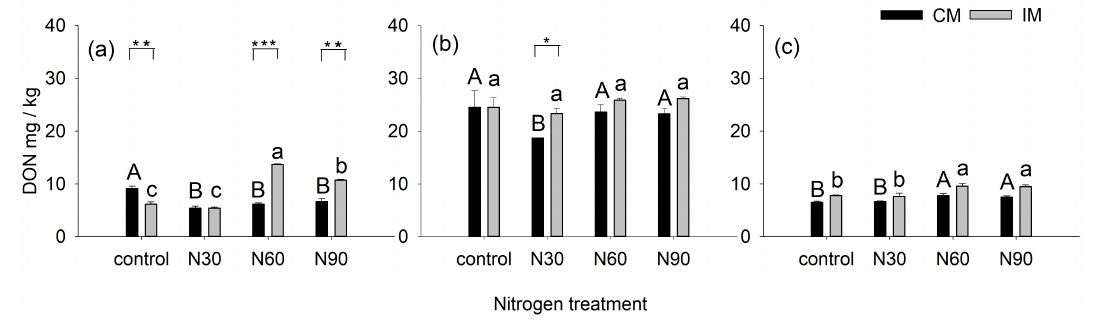
Figure 2. Dissolved organic nitrogen (DON) in surface soil (0–20 cm) in different seasons (( a ) April; ( b ) July; ( c ) December) under different management practices (CM: conventional management; IM: intensive management) and four nitrogen addition treatments (N30: 30 kg N ha − 1 year − 1 ; N60: 60 kg N ha − 1 year − 1 ; N90: 90 kg N ha − 1 year − 1 and Control: N-free). Vertical bars indicate the standard error of three replicates. Different uppercase letters indicate significant differences among N addition rates under CM treatments ( p < 0.05). Different lowercase letters indicate significant differences among N addition rates under IM treatments ( p < 0.05). Asterisks indicate significant differences between CM and IM at the same N addition rate (* p < 0.05, ** p < 0.01, *** p < 0.001).